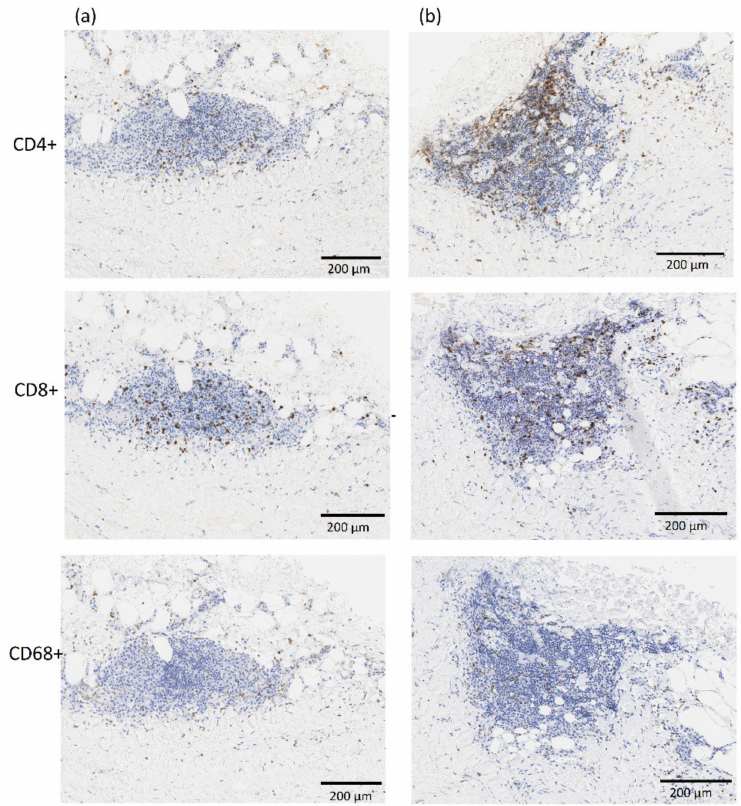
Figure 6. Representative images from immunostaining showing inflammatory infiltrate of CD4+, CD8+ and CD68+ cells in the neck—region RA1 (column a ) and aneurysmal dilatation—region RA3 (column b ) for one AAA patient in the population. The adventitia and media layers are in the top and bottom half of each image, respectively. All images are at 10 × magnification.